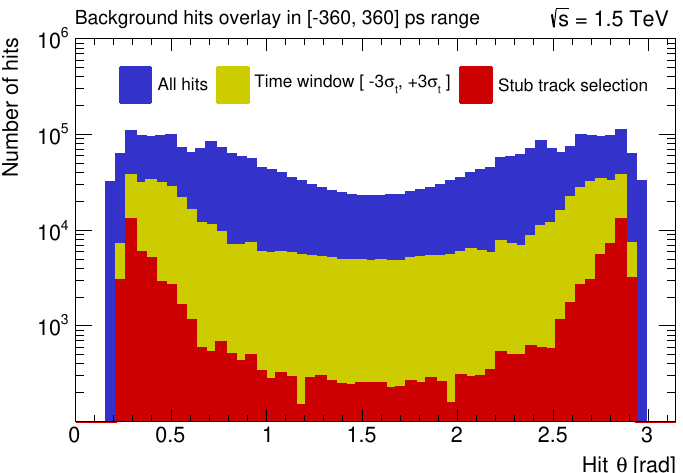
Figure 8. Hit density in the tracking detectors, shown as a function of the hit polar angle θ , for √ the BIB at s = 1 . 5 TeV. The category “all hits” depends on the time window that is selected for the BIB overlay inside the